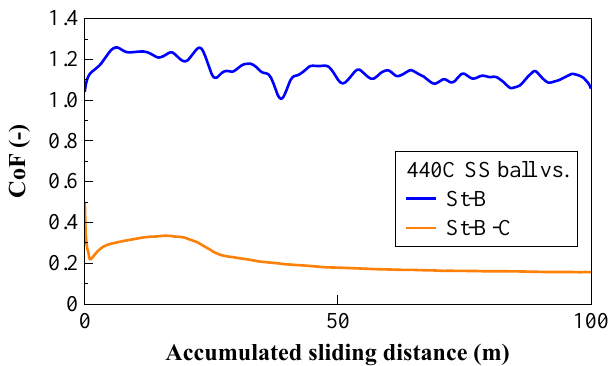
Figure 4. Coefficient of friction as a function of the accumulated sliding distance determined in the ball-on-disk setup using a 440C SS ball under dry conditions.